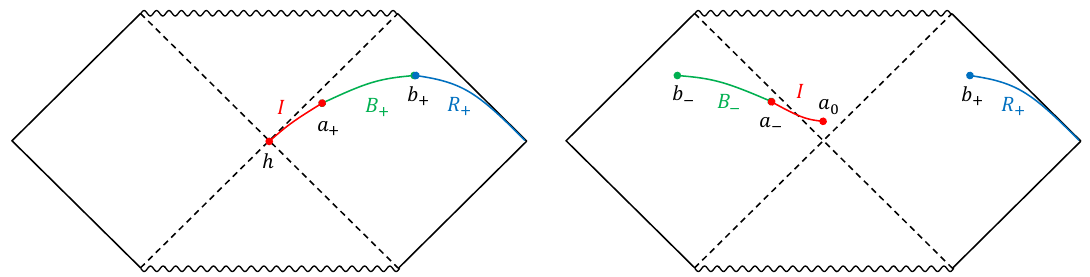
Figure 6 . The effective region of R + ∪ B + (left) and that of R + ∪ B − (right) include a half of the island. For R + ∪ B + , the quantum extremal surface is located at the bifurcation sphere of the event horizon, h . The region is simply a time slice in the right wedge, but it includes the island I . Thus the effective region of R + ∪ B + is given by R + ∪ B + ∪ I , but the island I is a half of that for R or B . The island for R + ∪ B − is also a half of that of R or B , but includes a region inside the event